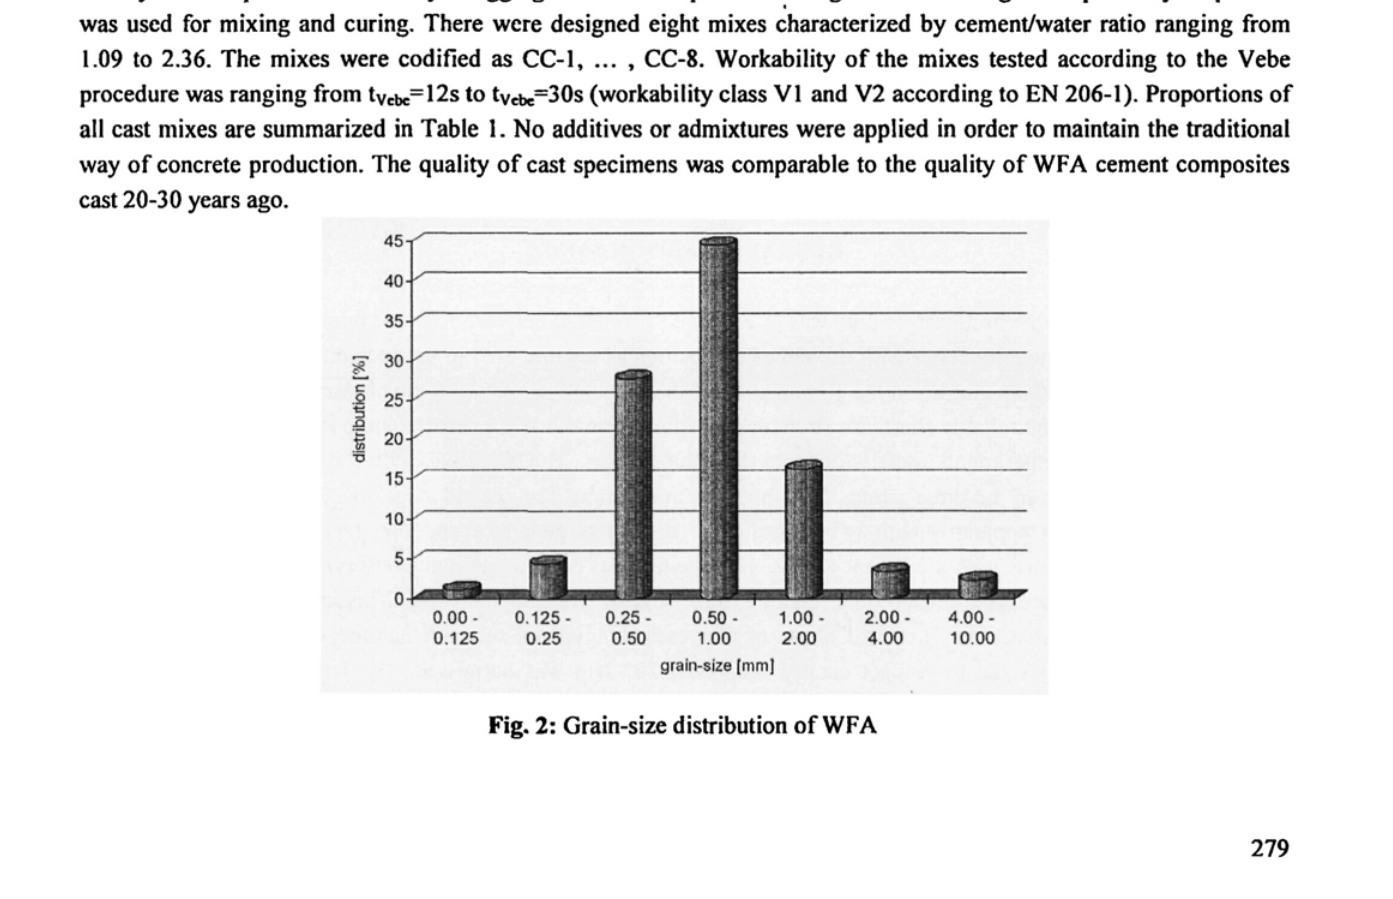
Fig. 2: Grain-size distribution of